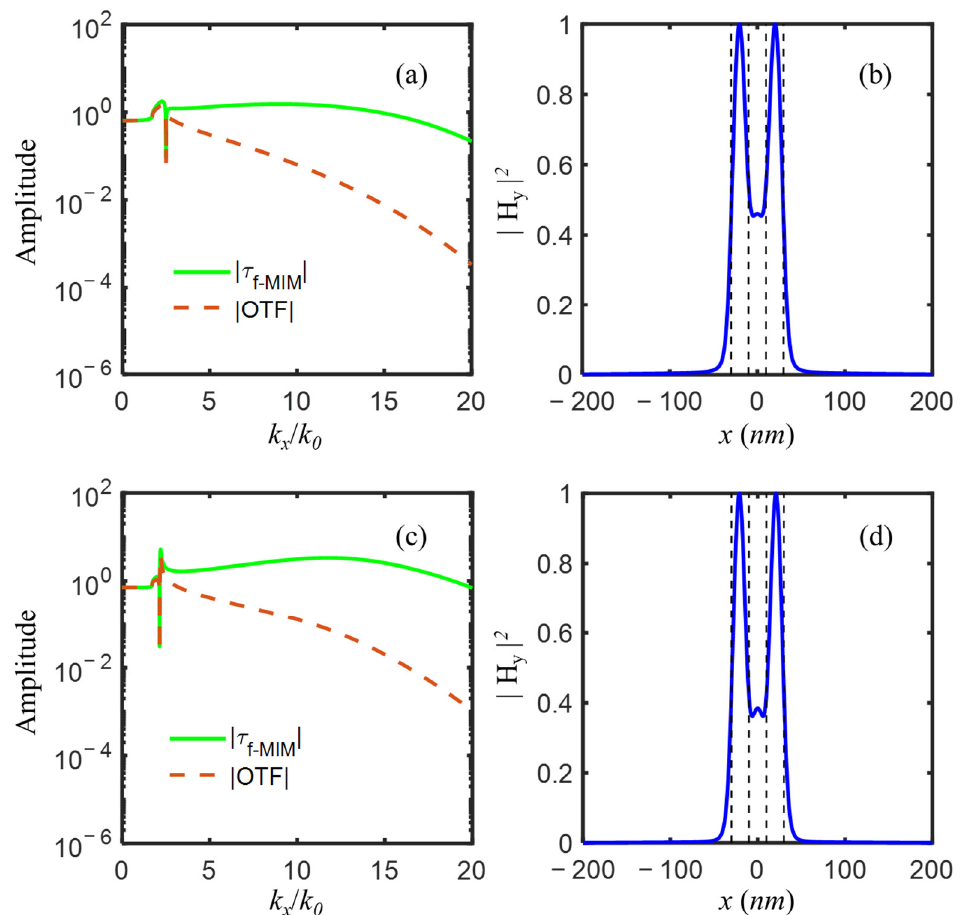
Figure 9. Completely cutoff s-LRSPP with ε p = 6.2 ( a ) The amplitude of optical transfer function | OTF | and transmission coefficient black dash lines; Approaching to cutoff s-LRSPP with ε p = 4.58 ( c ) The amplitude of optical transfer function | OTF | and transmission coefficient by black dash lines, for imaging system with the following parameters: ε s 1 = ε s 2 = − 4.43 + i 0.42, ε d = 4.08, ε q = 2.89, d s 1 = d s 2 = d p = d d = d q = 5